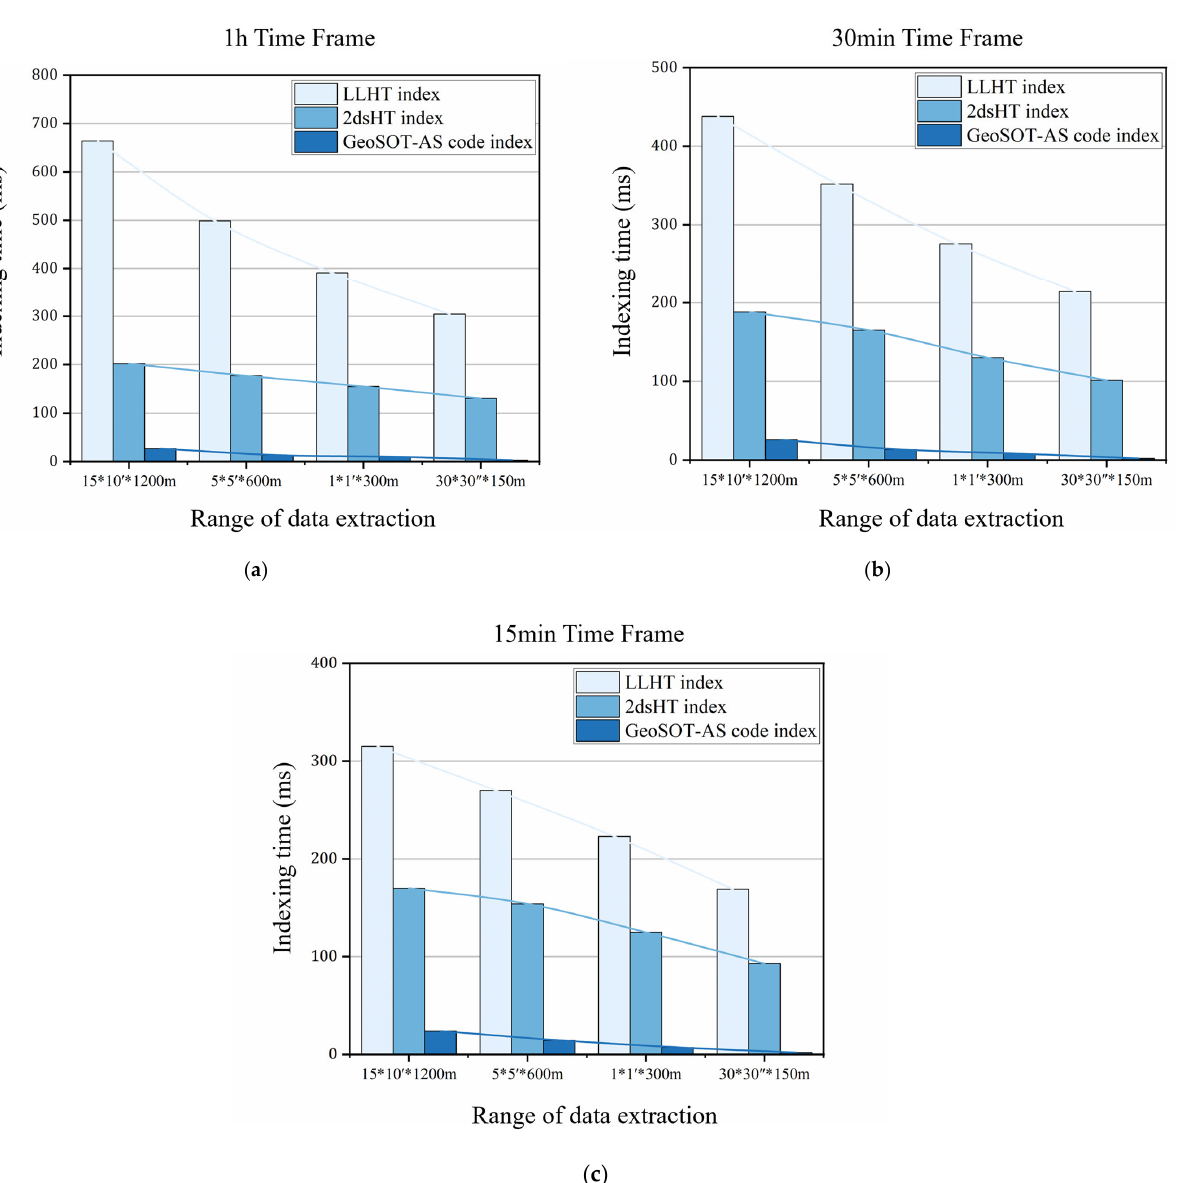
Figure 12. Regional and time segment data extraction performance test: ( a ) set the time frame to 1 h; ( b ) set the time frame to 30 min; ( c ) set the time frame to 15 min.